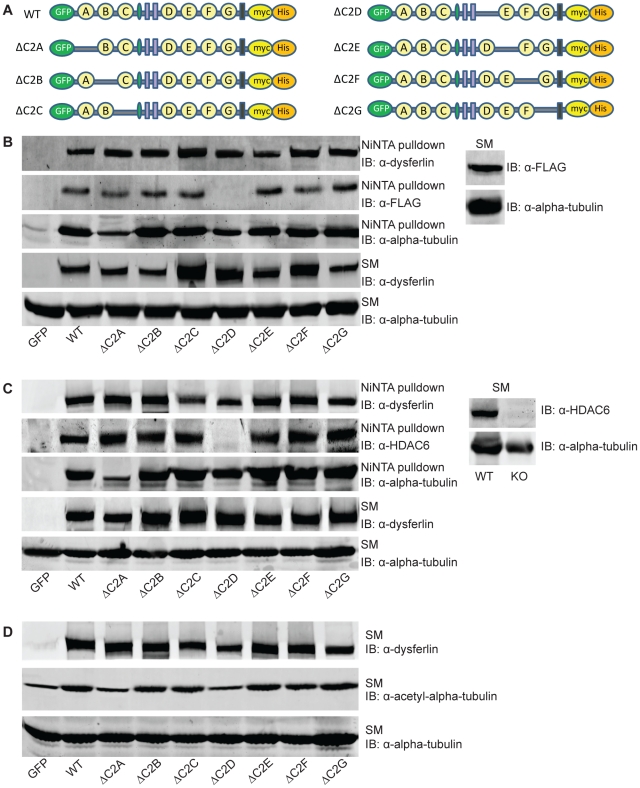
Dysferlin binds HDAC6 through its C2D domain and prevents alpha-tubulin deacetylation.(A) Schematic of dysferlin C2 domain deletion constructs. (B) Wildtype dysferlin (WT), dysferlin deletion mutants (ΔC2A through ΔC2G) or GFP vector were transfected in HEK293T cells, pulled-down on Ni-NTA beads, and incubated with FLAG-HDAC6-transfected HEK293T cell lysates. Immunoprecipitates were immunoblotted with the indicated antibodies. (Right panel) FLAG-HDAC6 expression levels in transfected HEK293T cell lysates, immunoblotted with anti-FLAG antibody. (C) Wildtype dysferlin (WT), dysferlin deletion mutants (ΔC2A through ΔC2G) or GFP vector were transfected in HEK293T cells, pulled-down on Ni-NTA beads, and incubated with murine testes homogenate. Immunoprecipitates were immunoblotted with the indicated antibodies. (Right panel) This western blot is identical to the one displayed in Fig. 1B. (D) Cell lysates from (C) were immunoblotted for alpha-tubulin acetylation levels. Similar results observed with cell lysates from (B) (not shown).